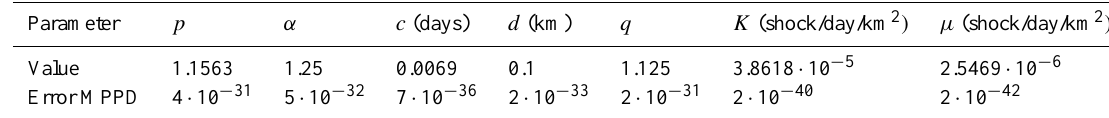
Table 3. Average values and error of the ETAS fit for magnitude higher than 2.